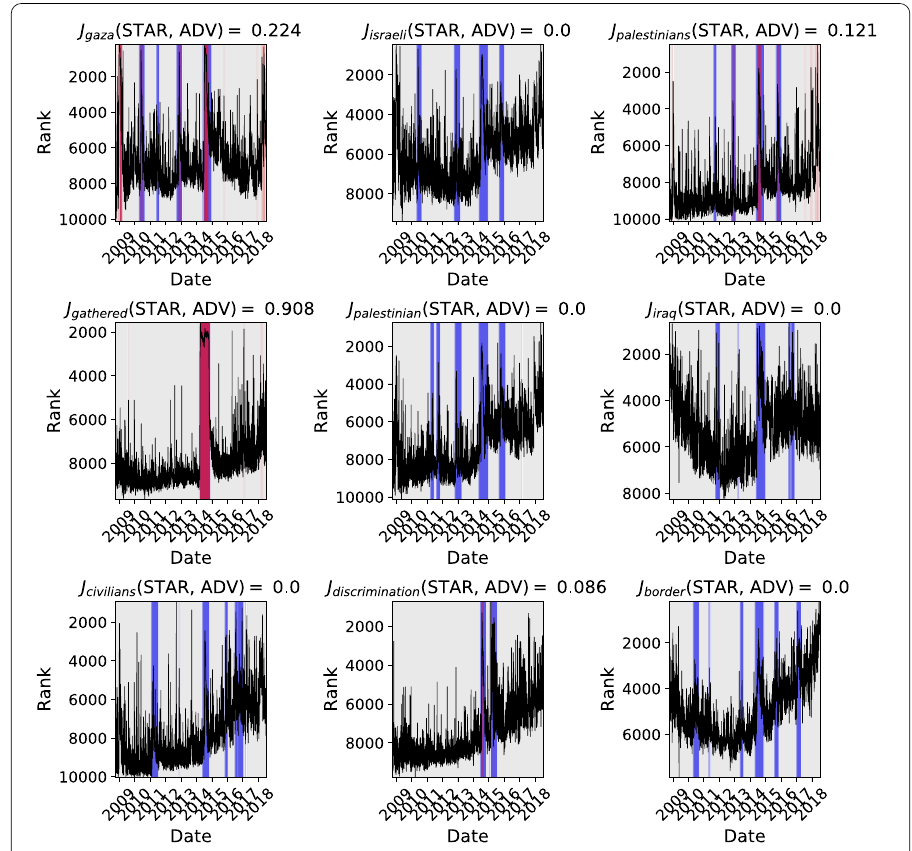
Figure 19 Gaza conflict. Comparison of STAR and ADV indicator windows for some words surrounding the Gaza conflict of